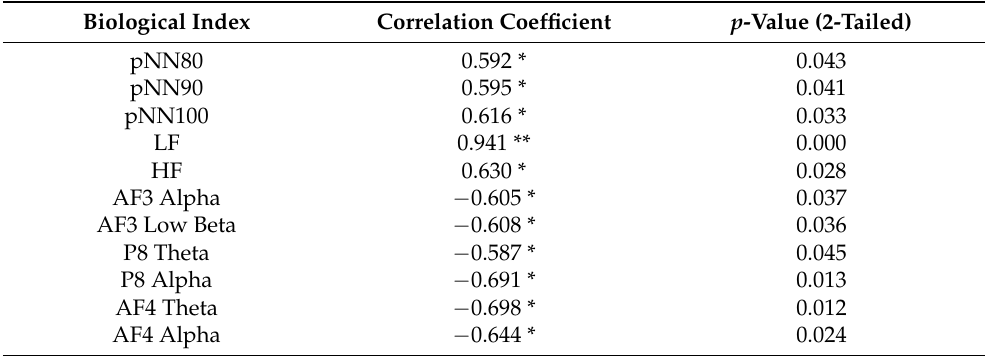
Table 9. Correlation coefficients between the number of errors in Task1 and the mean values of biological indexes during Task1 (during-error condition) (* correlation is significant at the 0.05 level; ** correlation is significant at the 0.01 level).